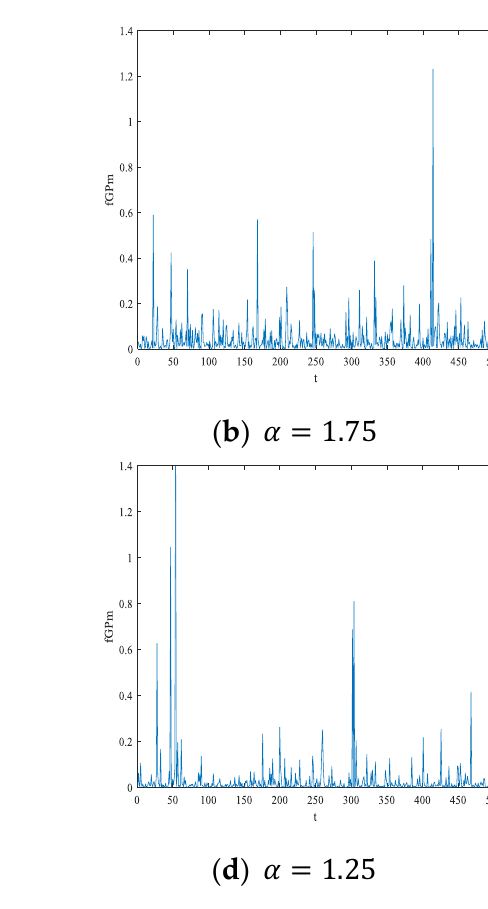
Figure 8. fGPm generated with different 𝛼 = 2, 1.75 , 1.5 , 1.25 , respectively, 𝐻 = 0.75 .